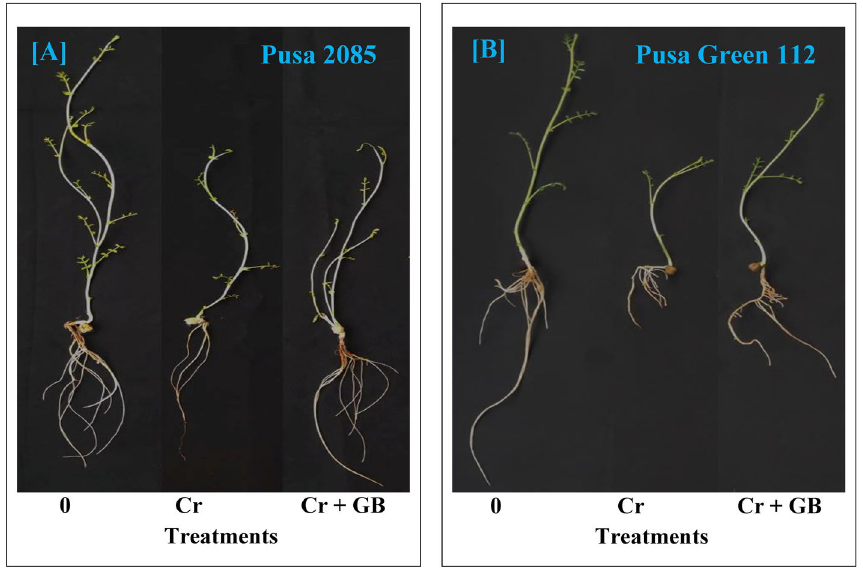
Figure 1. Effects of different stress levels of Glycine Betaine (GB) and Chromium (Cr), 0 and 120 μM Cr and 120 μM Cr + 100 mM (GB), on seedling growth performance of both chickpea cultivars: ( A ) Pusa 2085 and ( B ) Pusa Green 112 after 7 days of exposure (grown under hydroponics